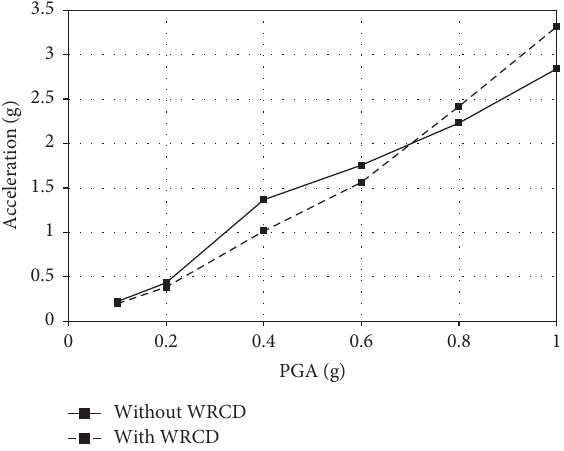
Figure 9: Maximum acceleration of 3# sliding pier top.